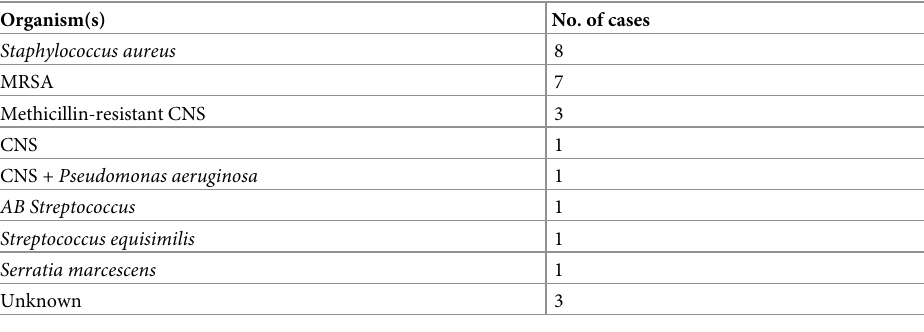
Table 4. Microbiological characteristics of